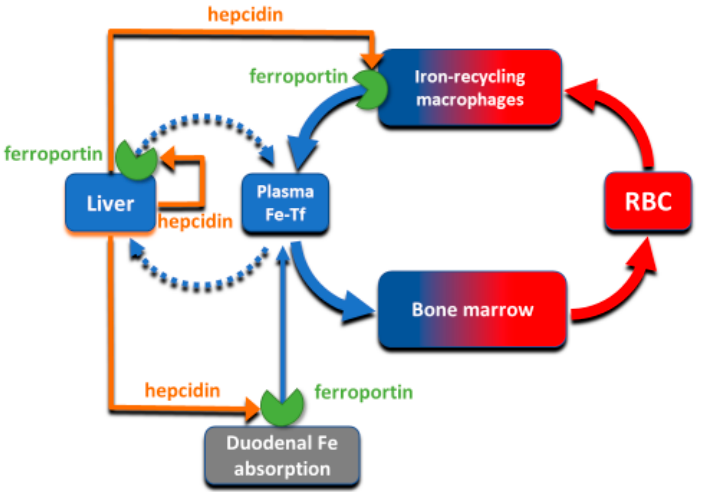
Figure 2. The interaction of hepcidin with ferroportin controls iron flows into